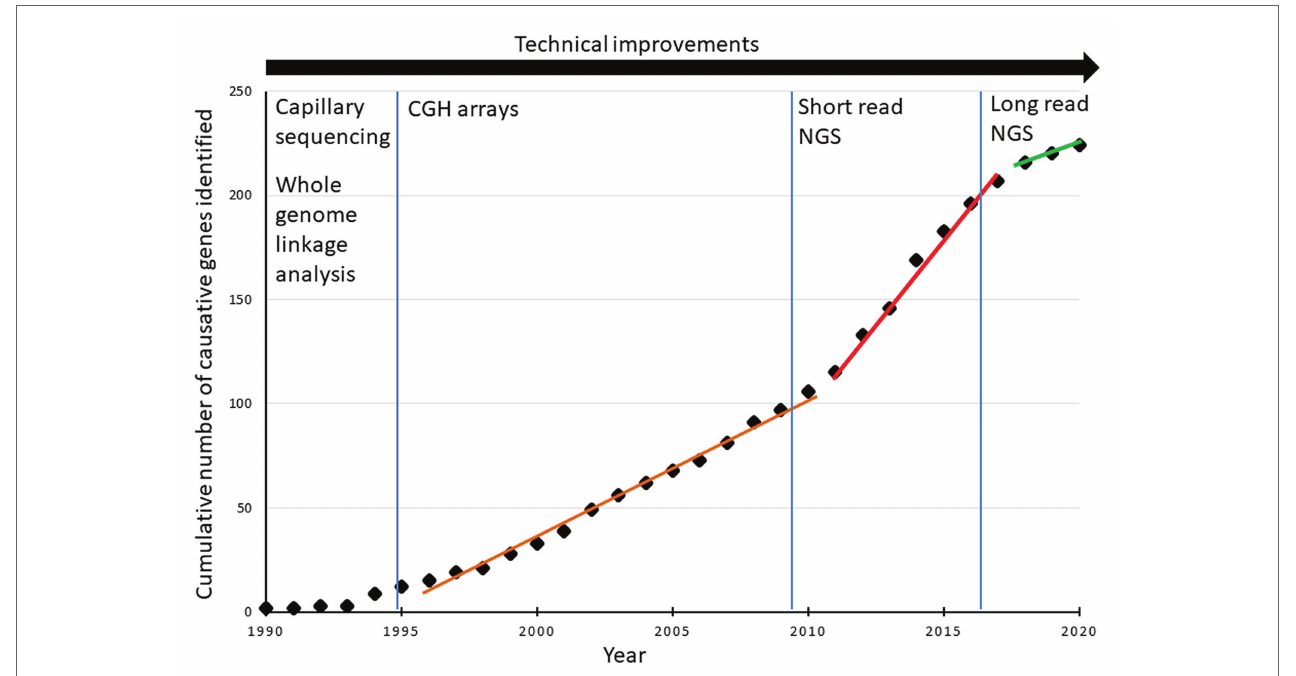
FIGURE 2 | Cumulative evolution of the number of subtypes of hereditary SCD identified per